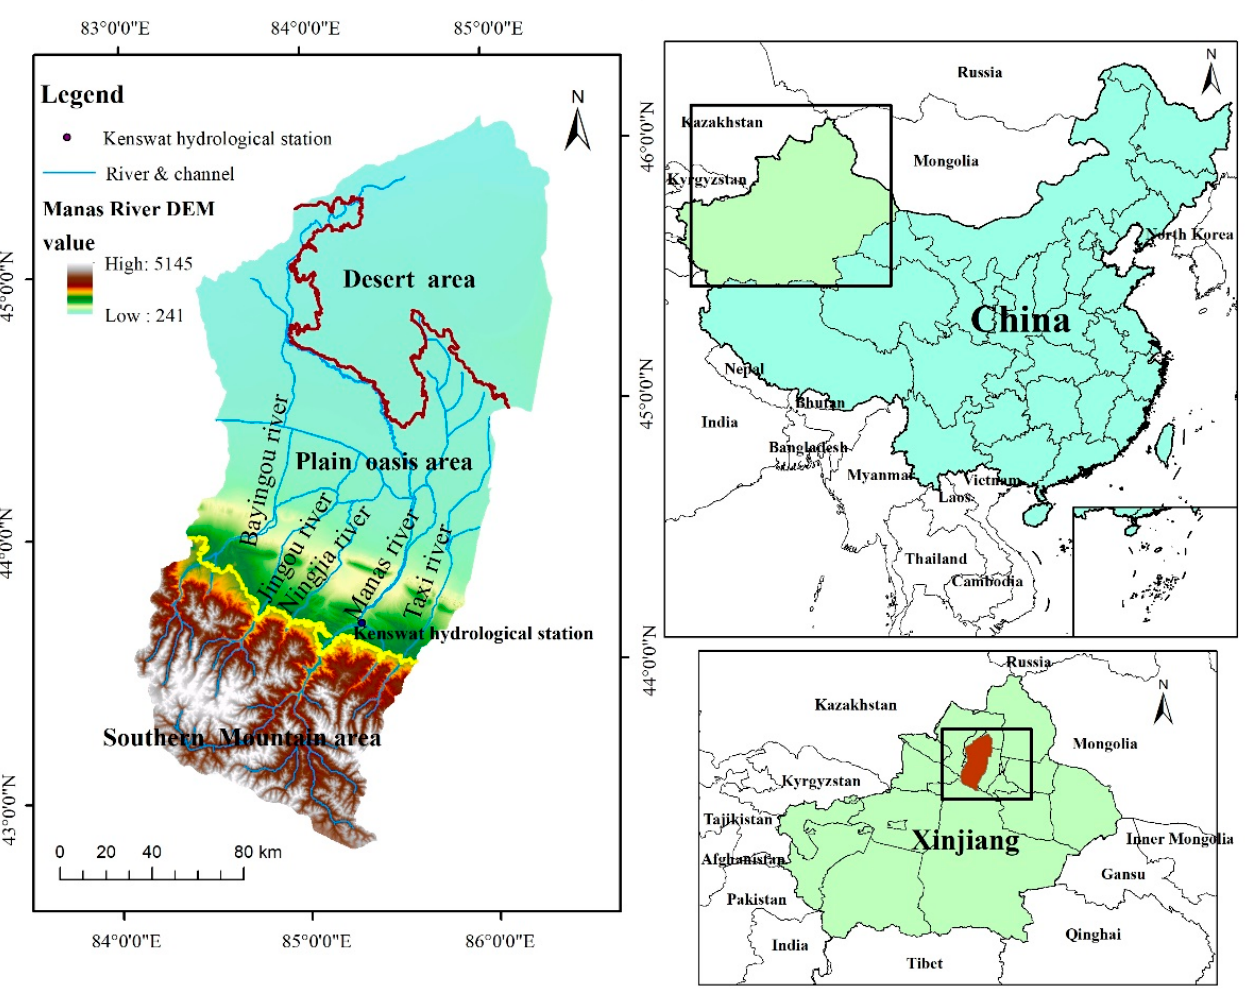
Figure 1. Location and overview of the study area.